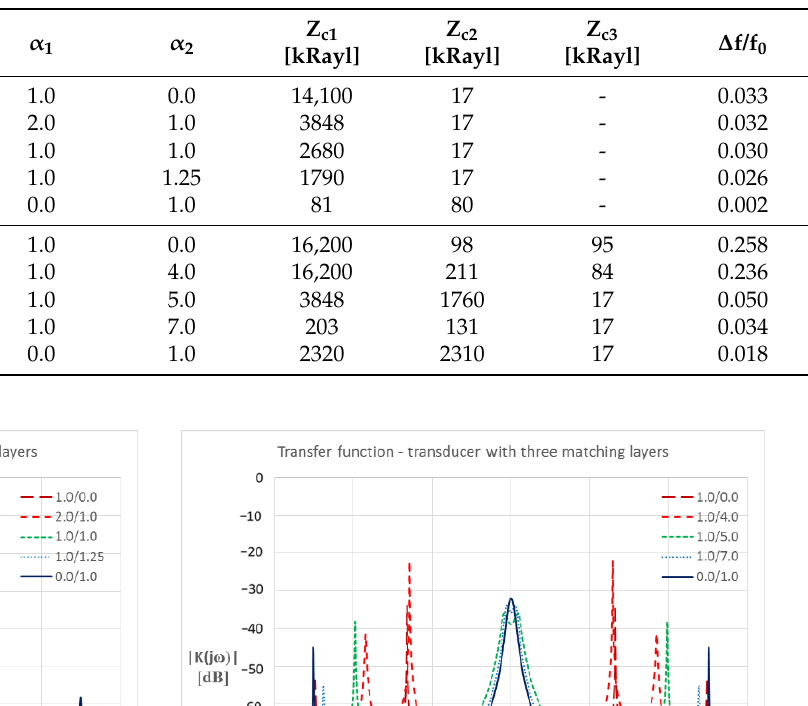
Table 1. Acoustic impedances of matching layers obtained with the genetic algorithm (air, Z T = 0.427 kRayl).